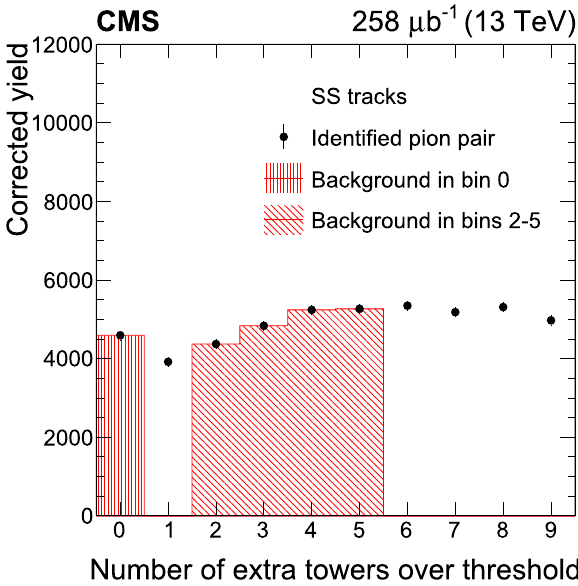
Fig. 3 Thenumberofextracalorimetertowersoverthresholdinevents containing an identified pion pair with opposite (left) and same (right) charge. The known contributions, denoted with the red hatched areas, are used to estimate the background in the zero bin of the opposite-sign